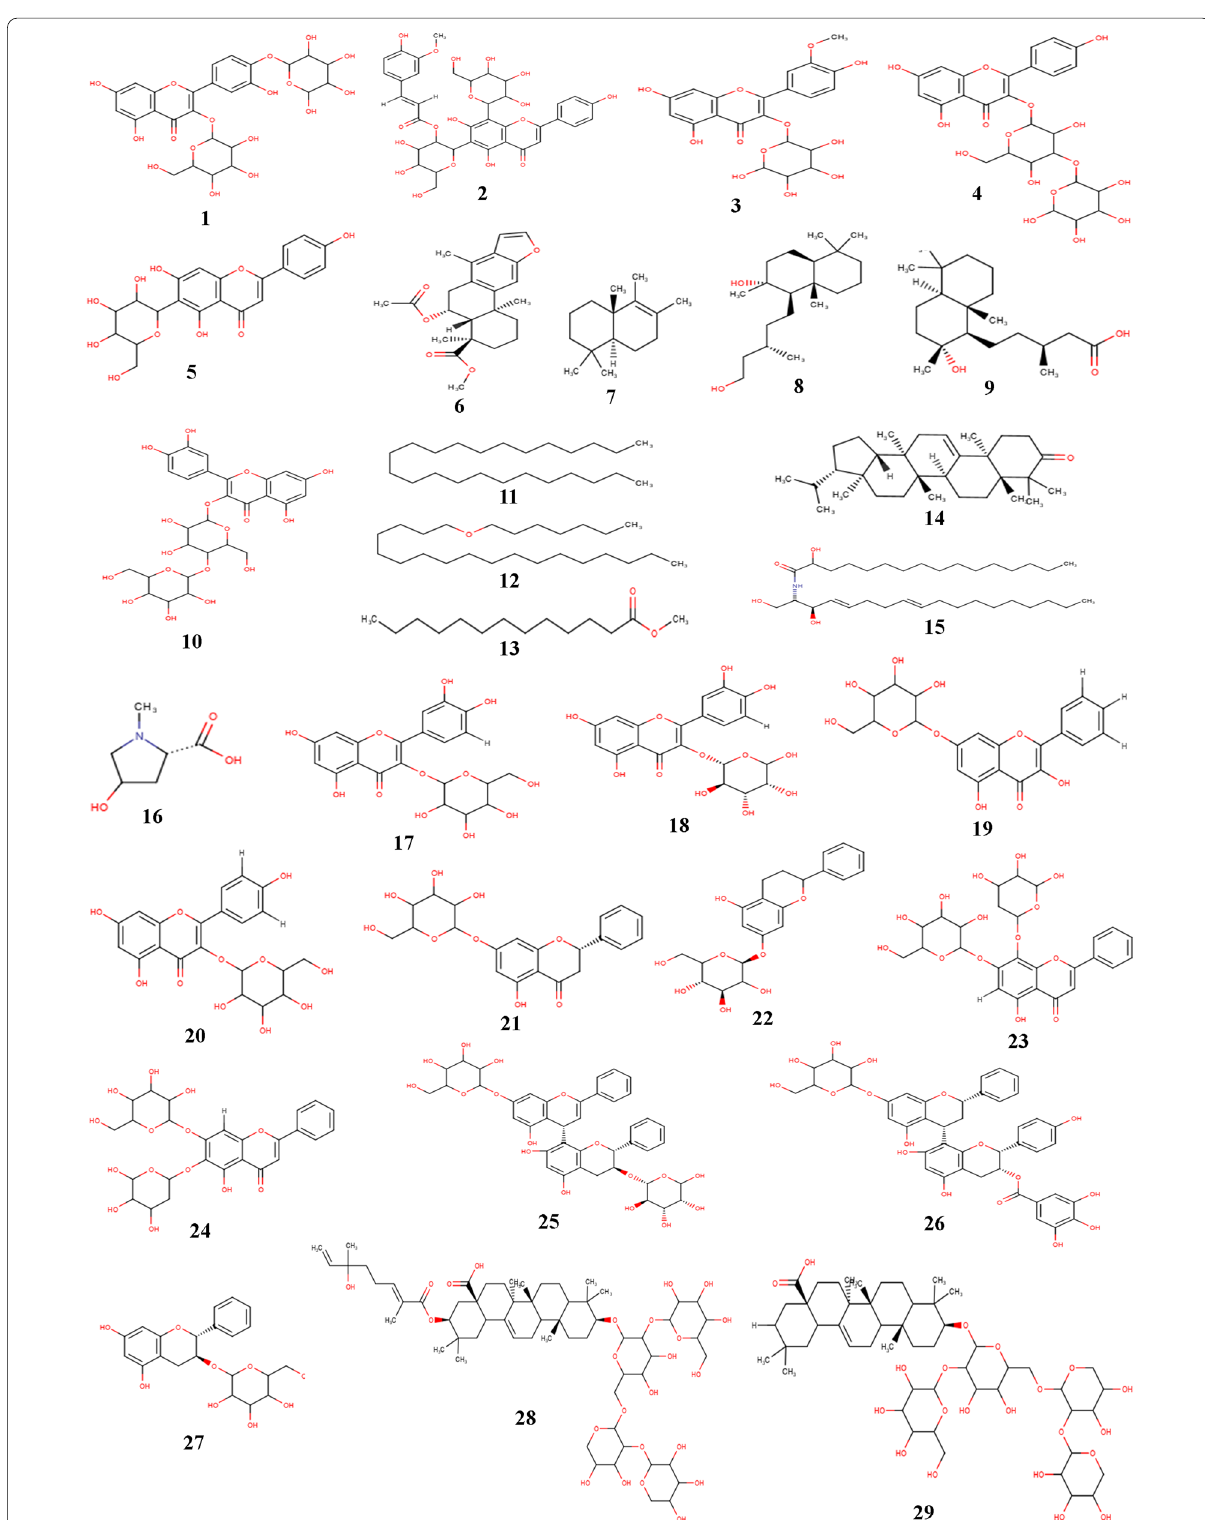
Fig. 3 Chemical structures of phytocompounds reported to be isolated from A.